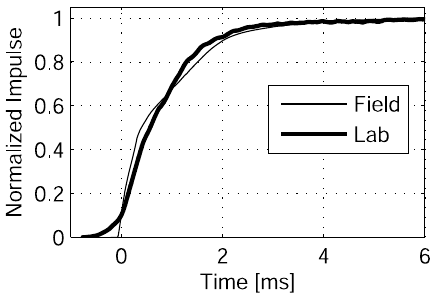
Fig. 5. Comparison of typical impulse time history shapes.